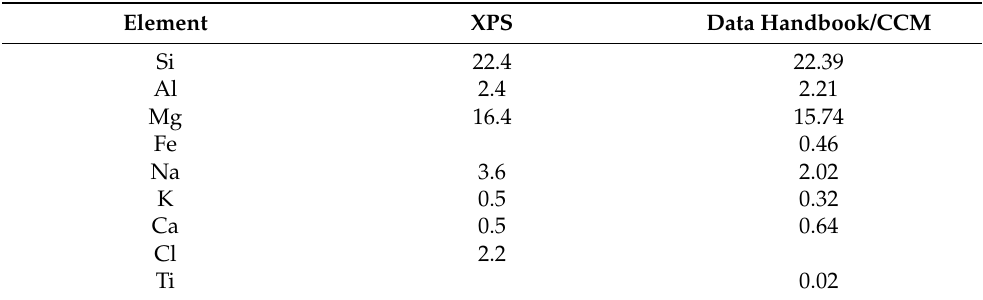
Table 5. Chemical composition of saponite SapCa-2 (in atom %) based on survey XPS analyses with Si as reference in comparison to data (in atom %) from Data handbook for Clay Minerals and Other Non-metallic Minerals [88] and Clays and Clay Minerals Special Issue 49 (5) Source Clays (2001) [89]. Oxygen is not